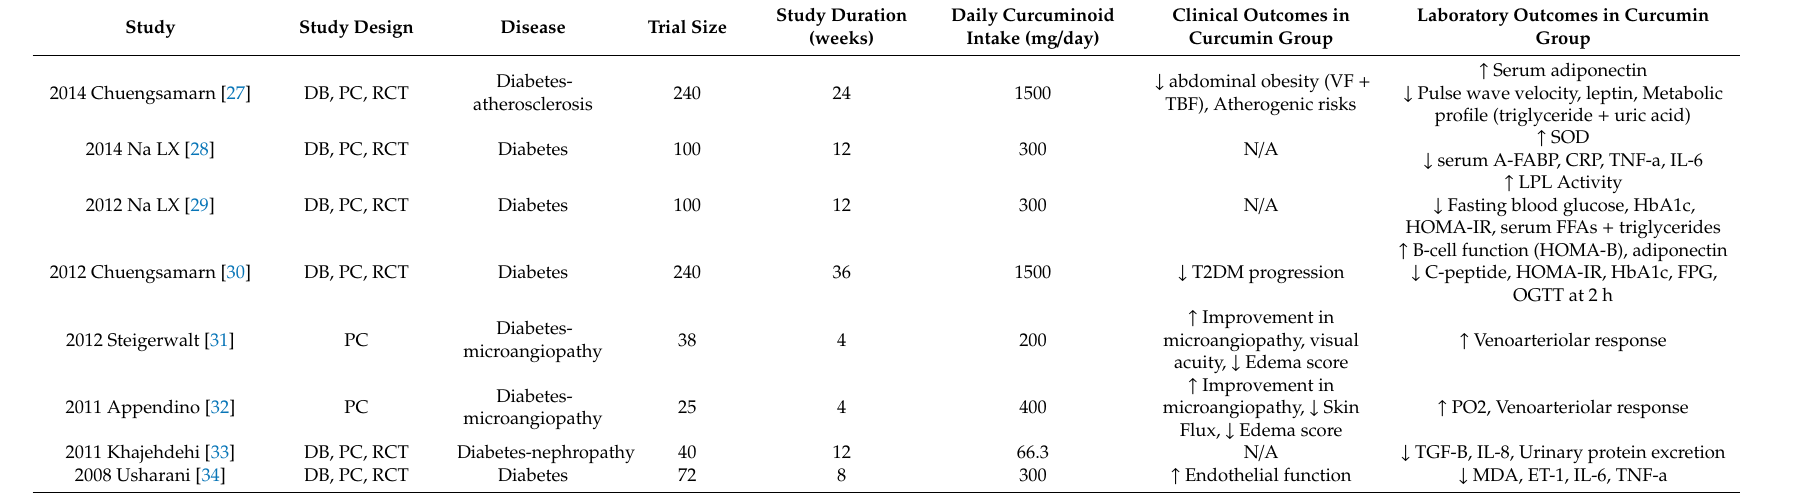
Table 2. Clinical e ffi cacy of curcumin supplementation in type 2